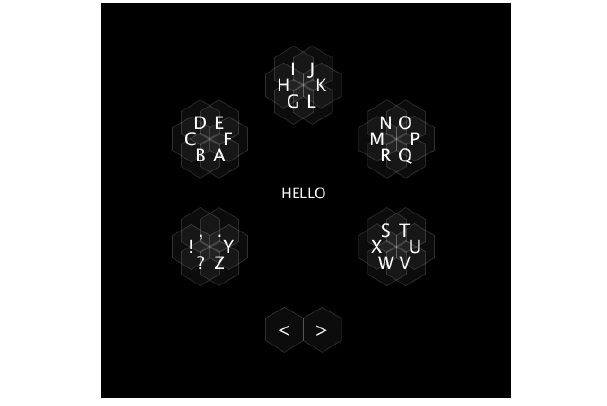
Figure 1 . Cluster and character layout of SMOOVS in Phase 0 with current word in the central area SMOOVS Figure 2 . Interaction: display